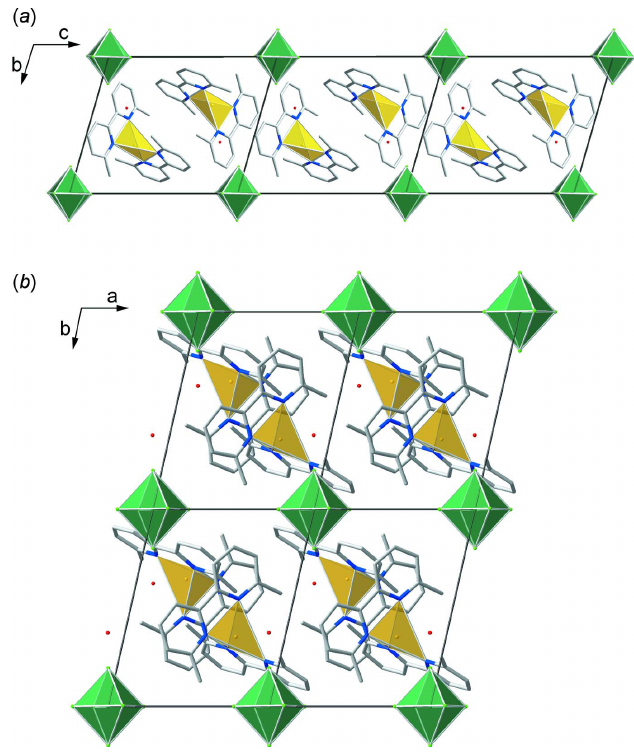
Figure 3 The packing for (I) viewed ( a ) down [100] and ( b ) down [001], with the copper and zirconium coordination environments represented by yellow/ orange and green polyhedra, respectively.